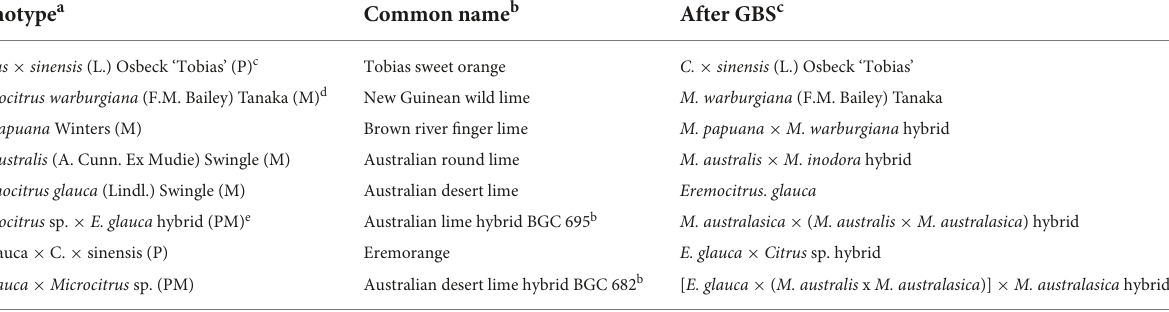
TABLE 2 Genotypes used in this study, their common names, and phylogenomic constitution after genotyping by sequencing (GBS)